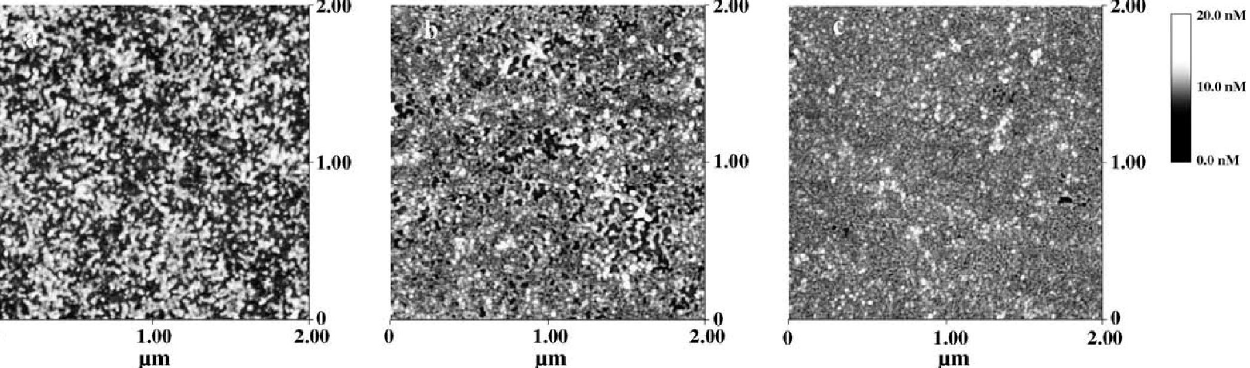
Figure 6. Above: AFM 2D images of immobilized lipase: ( a ) 1 layers; ( b ) 5 layers; ( c ) 10 layers of lipase. 50 µL of lipase at a concentration of 10 mg/mL was dispersed onto the air/water interface and immediately compressed. Monolayers were sequentially deposited at 20 nN/m onto a silicon slide for analysis. Center: Lineweaver–Burke plots of olive oil activity of the free (upper plot) and LB film-contained (lower plot) lipase. One LB monolayer of lipase was used for the immobilized enzyme corresponding to 10−4 mg of free enzyme. Below: MALDI TOF MS spectrum of recombinant Laccase from Rigidoporus lignosus. The spectrum was acquired in linear mode and the matrix utilized was sinapinic acid. The spectrum was calibrated externally by Protein standard solution II (Bruker). The peak at m/z = 56516 ± 94 has been assigned as a Laccase one; the other peaks at m/z = 28520 ± 83, m/z = 27549 ± 44 and m/z = 18374 ± 22 have been interpreted as different domains of Laccase erroneously expressed by the